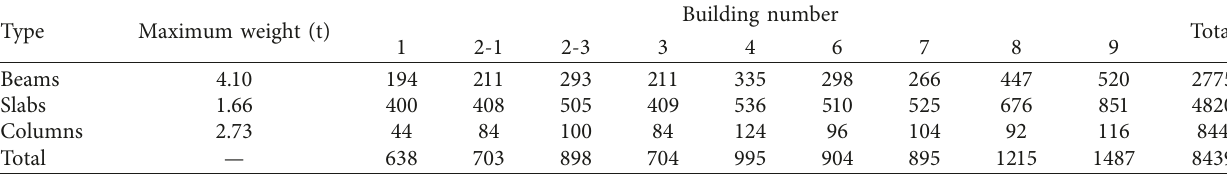
Table 6: Prefabricated components information.